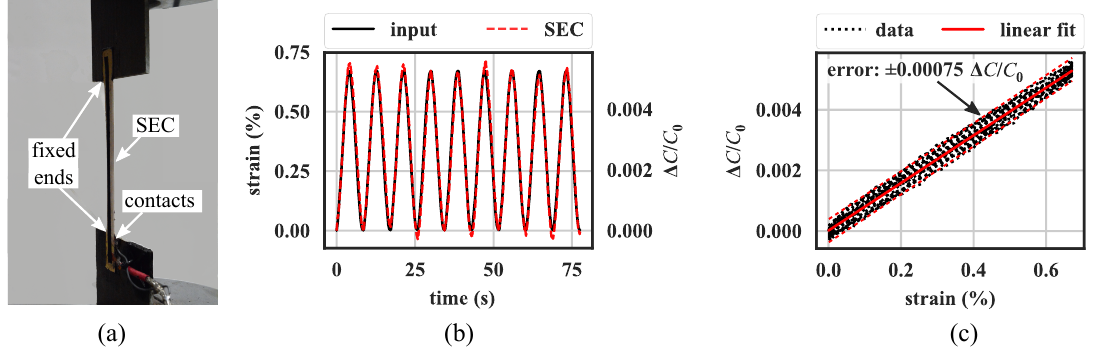
Figure 2. ( a ) Experimental gauge factor characterization test setup; ( b ) capacitance time history response subject to cyclic strain input; and ( c ) sensitivity and linearity of the sensor.